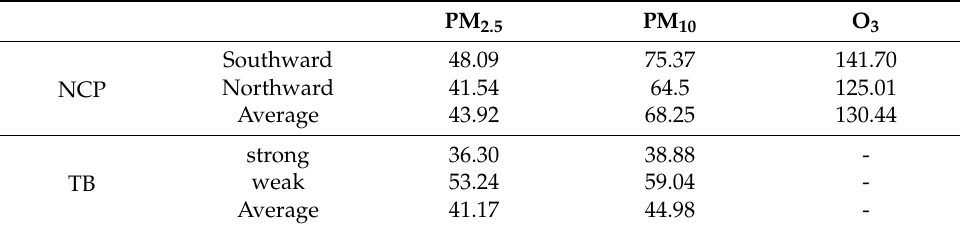
Table 3. The average concentration of the air pollutants in North China Plain (NCP) and the Tarim Basin (TB) in different East Asian jet periods in summer from 2013–2018. (units: µ g · m − 3 ). PM 2.5 PM 10 Southward Northward NCP strong weak